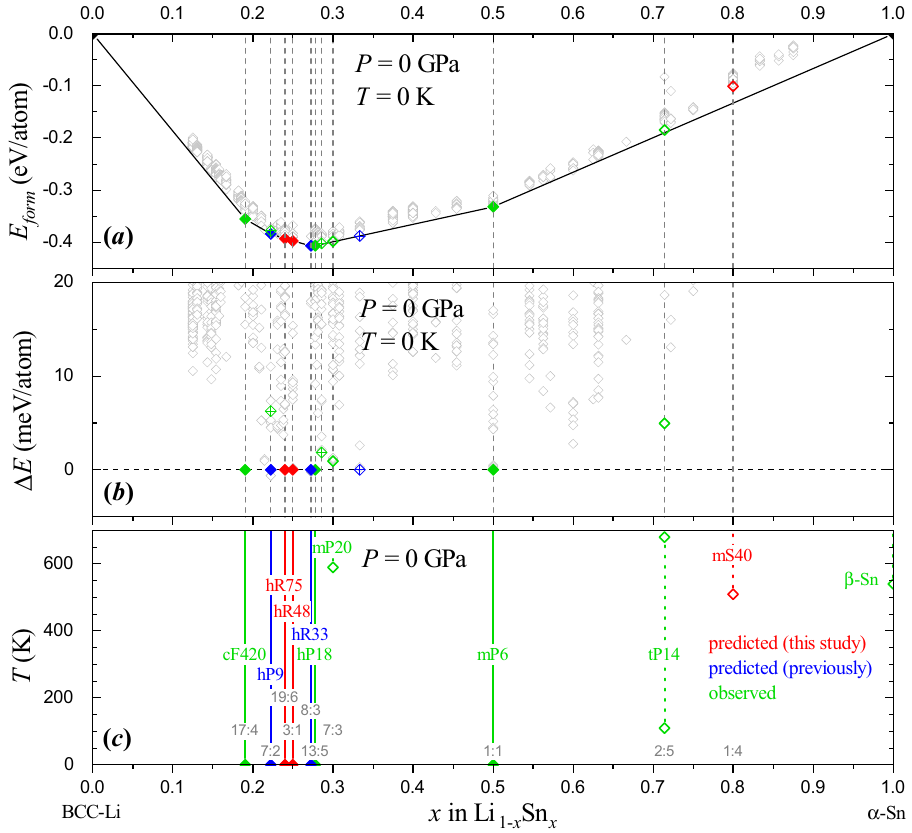
Fig. 3 DFT thermodynamic stability analysis of Li-Sn alloys at P = 0 GPa. The Li-B phases observed experimentally, proposed previously 47,50 , and predicted in this study are shown in green, blue, and red, respectively. The solid (open) symbols denote phases stable at zero (elevated) temperatures, while the crossed symbols correspond to phases that remain metastable at all considered temperatures. a The convex hull at T = 0 K. b The distance from the convex hull at T = 0 K. c The temperature range of phase stability. The identi fi ed thermodynamically stable phases shown in red are hR75-Li 19 Sn 6 , hR48-Li 3 Sn, and mS40-LiSn 4